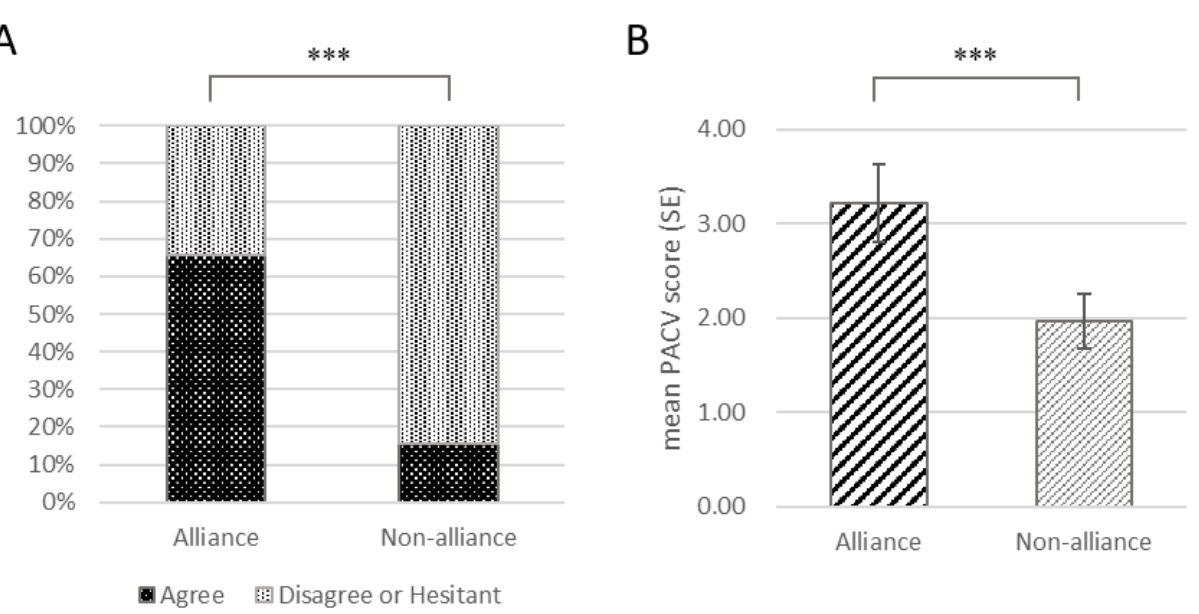
Figure 2. The comparison of parental wiliness against COVID-19 vaccine and non-COVID vaccines between the alliance group and nonalliance group (both in matched samples). ( A ), the willingness to vaccination in the alliance group was significantly higher than in the nonalliance group ( p < 0.001); ( B ), there was a significant difference in the mean “Parent Attitudes about Childhood Vaccines” questionnaire (PACV) scores between the two groups (*** p <0.001).